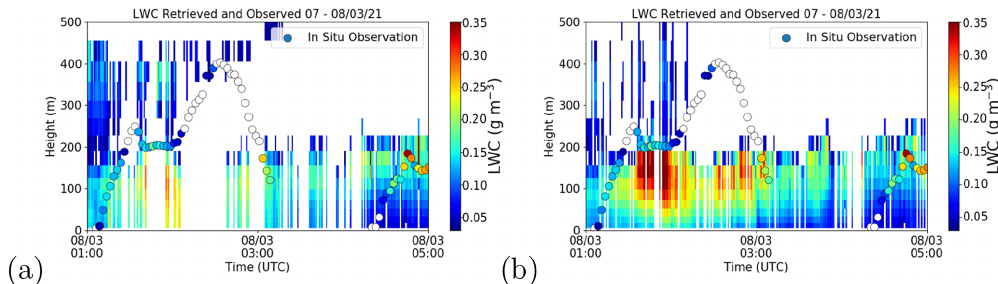
Figure 9. Retrievals performed when Jacobians are not forced to be positive. Retrievals made using (a) the nearest profile background and (b) the MRP background for the same fog event on 7–8 March 2020, between 01:00 and 05:00UTC. The retrieval is shown in the background, while in situ observation are shown as circles. Where the retrieval failed to converge, the profile is left